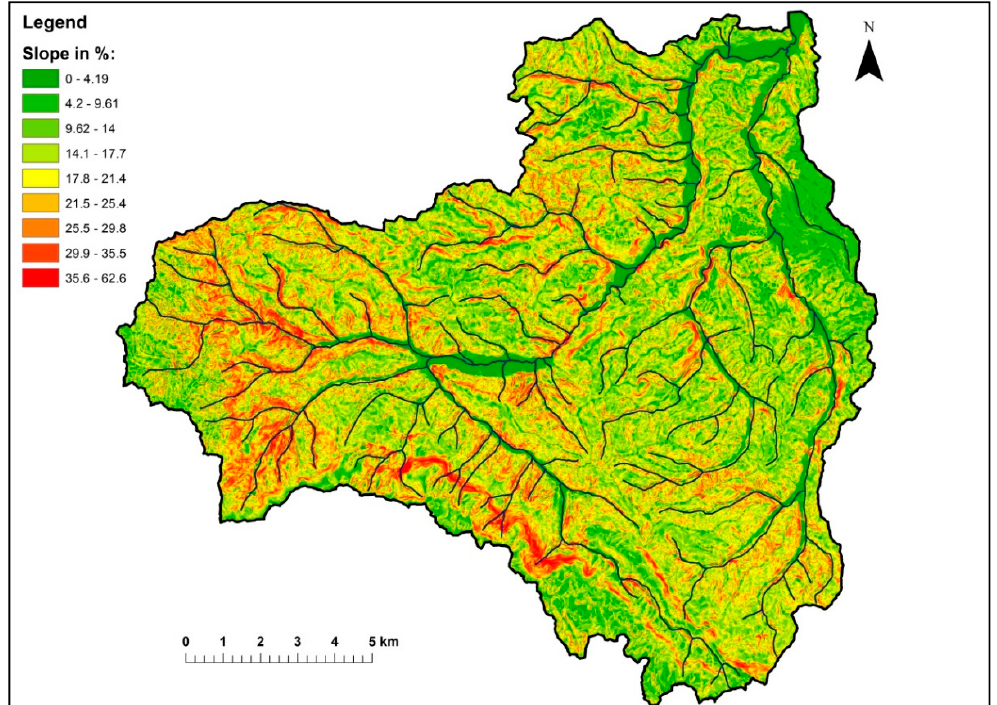
Figure 3. Slopes in the Likodra river basin